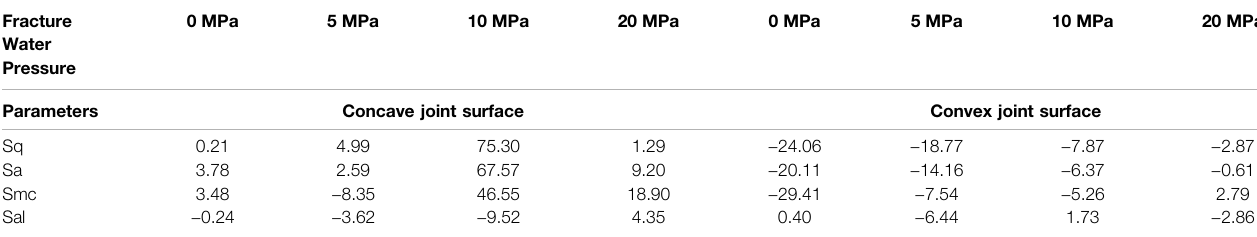
TABLE 4 | The change rate of morphological parameters of saturated rock samples (%). Fracture